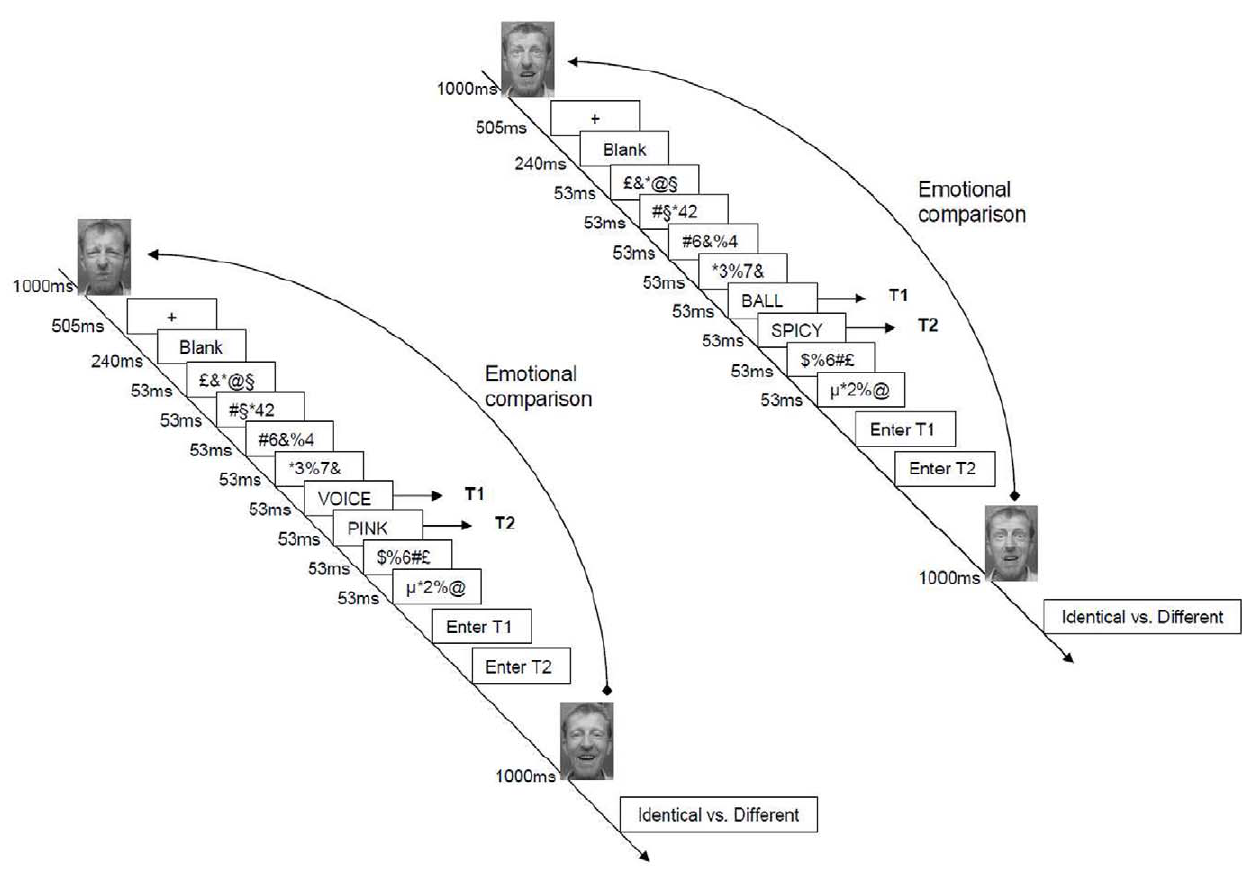
Figure 1. Schematic overview of typical trials with a stimulus onset asynchrony (SOA) of 53 milliseconds. Each trial started with the presentation of a facial expression directly followed by the rapid serial visual presentation (RSVP). Each stimulus was presented one at a time in the center of the screen for 53 ms. After the participants entered the target words (T1 and T2) they saw, they made a emotional comparison judgement (identical vs different) of the second face (different on the left sequence and identical on the right sequence). For the need of this figure, the pictures were not taken from the MSFDE as in the experiment but represent the first author of the paper (N.V.).